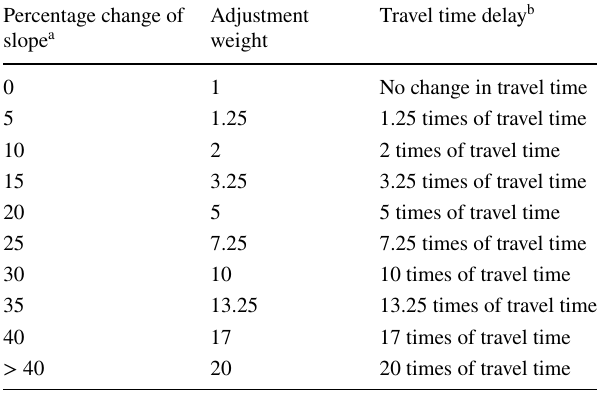
Table 3 Slope effect on travel time of fire trucks in the Chalkidiki study